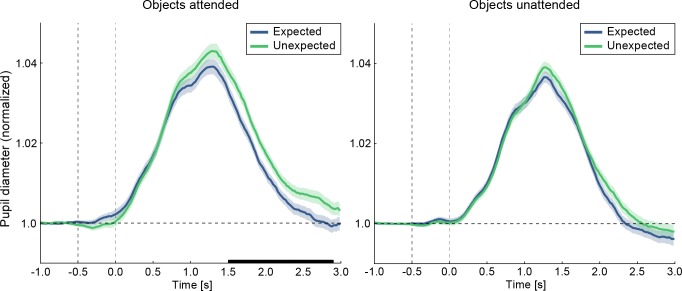
Larger pupil dilations in response to unexpected compared to expected stimuli during the objects attended task.Displayed are pupil diameter traces over time, relative to trailing image onset. Pupil diameter data for expected (blue) and unexpected (green) image pairs are shown for the objects attended task (left) and objects unattended task (right). The black line on the abscissa denotes statistically significant differences in pupil dilations between expected and unexpected images (cluster permutation test, p<0.05). In the objects attended condition significantly larger pupil dilations in response to unexpected images are evident between 1.52 to 2.88 s after trailing image onset (left). No significant difference is found in the objects unattended condition (right), nor in the interaction between conditions. The first vertical dashed line indicates leading image onset, the second vertical line trailing image onset. Shaded areas denote within-subject SE. Timepoints from −1.0 to −0.5 s served as baseline period.10.7554/eLife.47869.010Figure 3—source data 1.Larger pupil dilations in response to unexpected compared to expected stimuli during the objects attended task.The source data file contains the preprocessed pupil diameter traces (participants by timepoints) for each of the four experimental conditions separately (two attention by two expectation conditions).